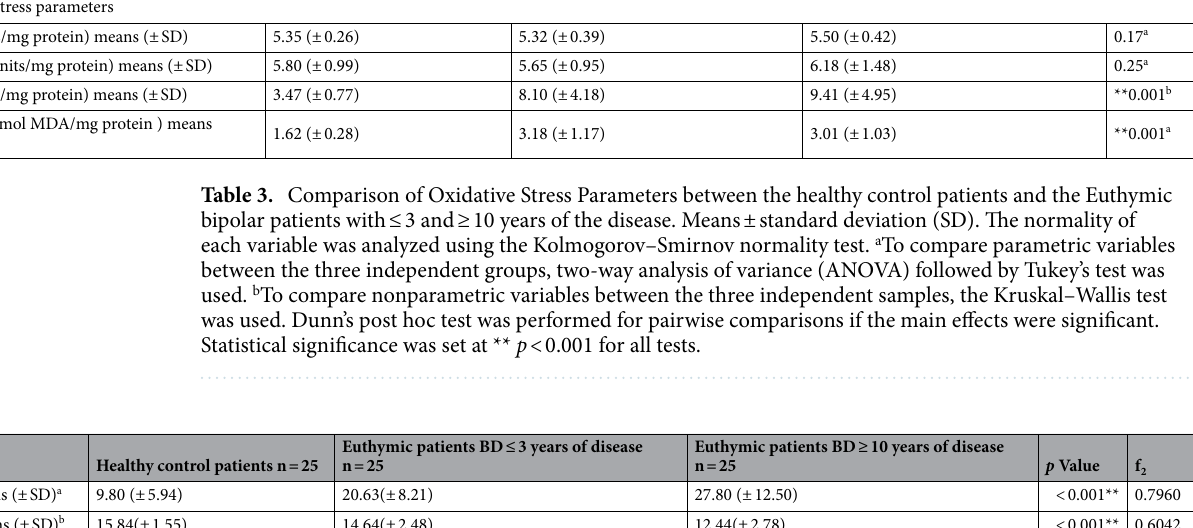
Healthy control patients n = 25 Euthymic patients BD ≤ 3 yearsn = 25 Euthymic patients BD ≥ 10 years n = 25 p – Value